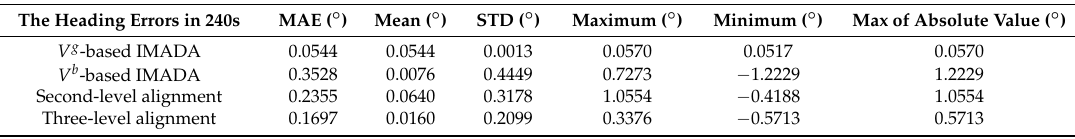
Table 2. Statistics of the 50 heading alignment errors in 240s.